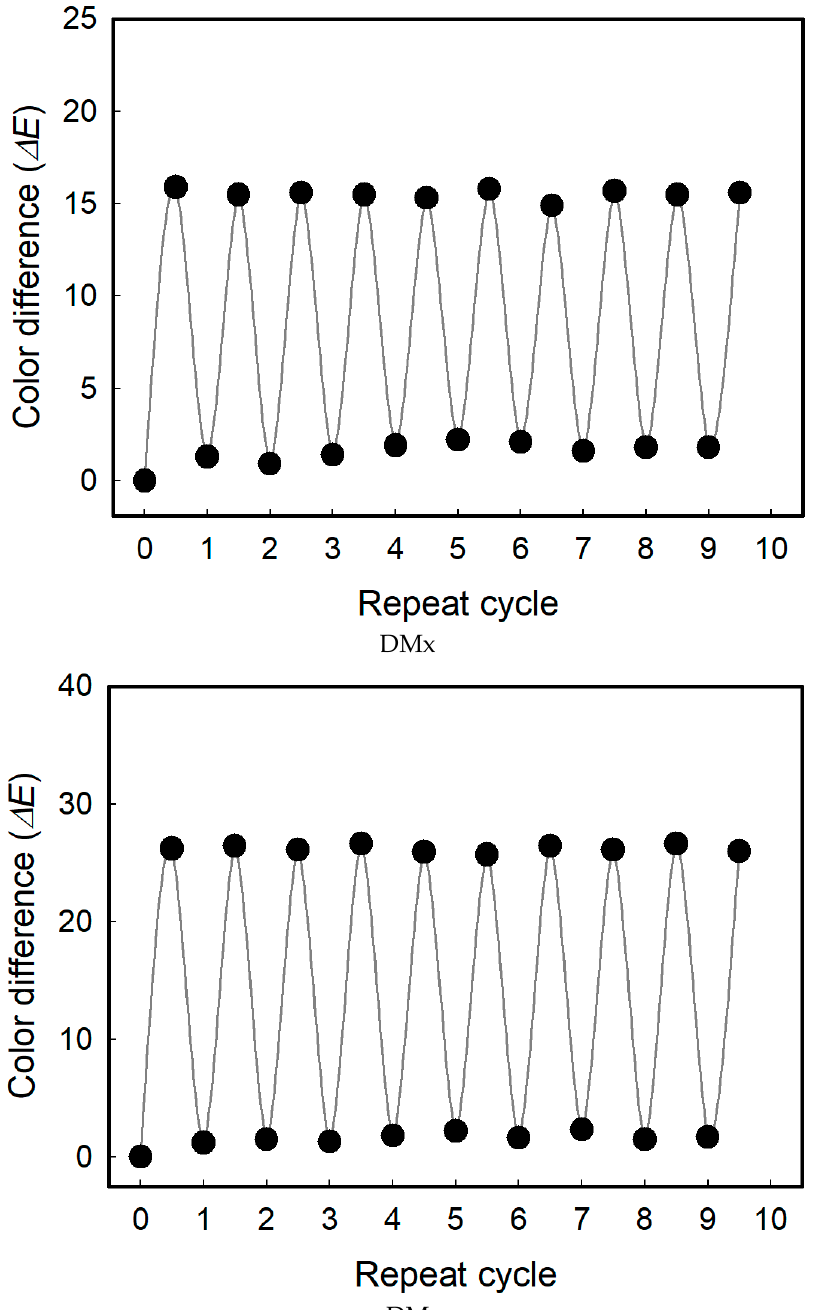
Figure 12. Reusability of the textile-based vapor sensors.